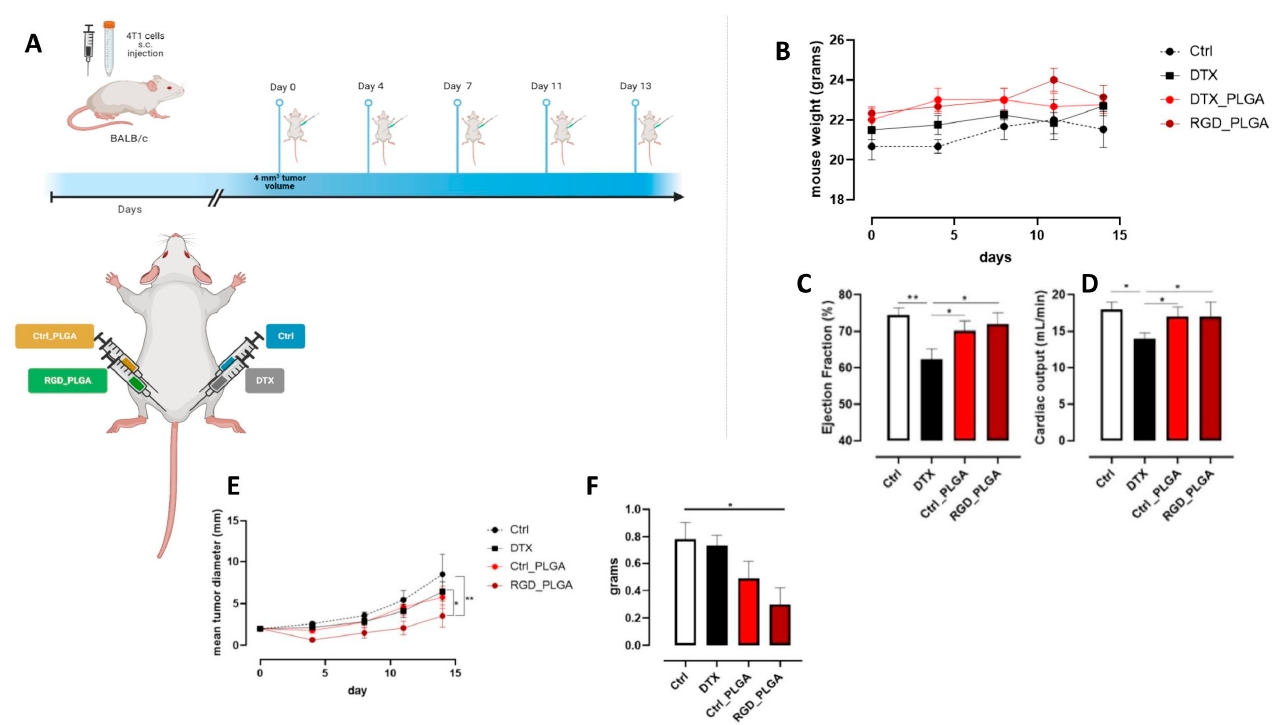
Figure 6. In vivo effect of PLGA-NPs. ( A ) BALB/c mice were orthotopically challenged with 1 × 10 4 4T1 cells. When the tumors reached 2 mm in diameter, the mice were treated with RGD_PLGA, Ctrl_PLGA, free docetaxel, or physiological saline solution as a control (N = 6 per group). The treatment was repeated twice per week for a total of 5 administrations. Graphs show ( B ) mouse weight, ( C ) heart ejection fraction (EF%) as assessed by cardioMRI, ( D ) heart cardiac output (CO) as assessed by flash cine cardioMRI, ( E ) mean tumor diameter, and ( F ) tumor weight at the end of the experiment. *, p < 0.05; **, p < 0.01; two-way ANOVA ( F ), unpaired Student’s t test ( C , D ) or Mann–Whitney test ( E ). Panel A was created with Biorender.com.